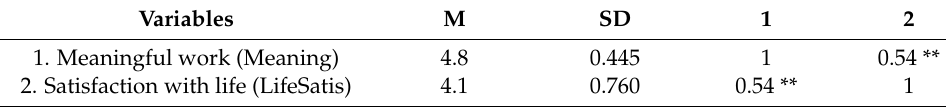
Table 2. Means, standard deviations, and correlations.